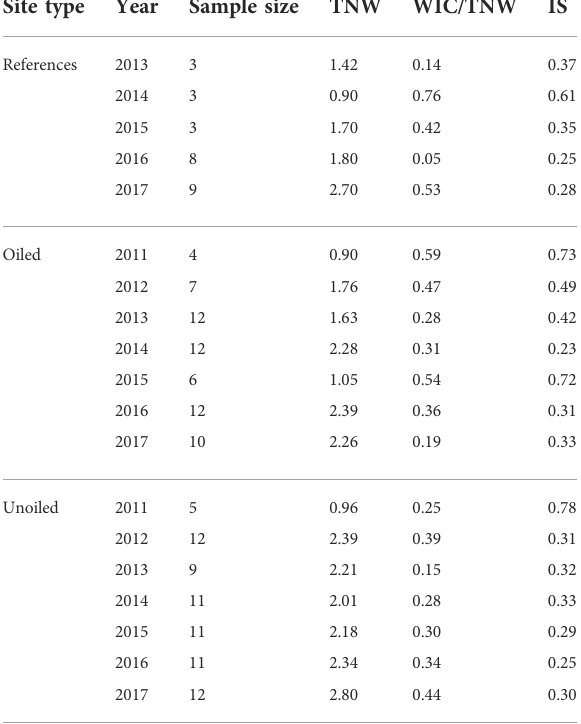
TABLE 1 Sample size, TNW, and both metrics of individual specialization (WIC/TNW and IS) of Seaside Sparrows, broken down by year and site type. Sparrows that did not produce metabarcoding results are not included in the sample size. The average measure of total niche width (TNW) and individual specialization were calculated by WIC/TNW and through the PSicalc function (IS). All values of WIC/TNW and IS have p < 0.05. Note that reference sites were not established until